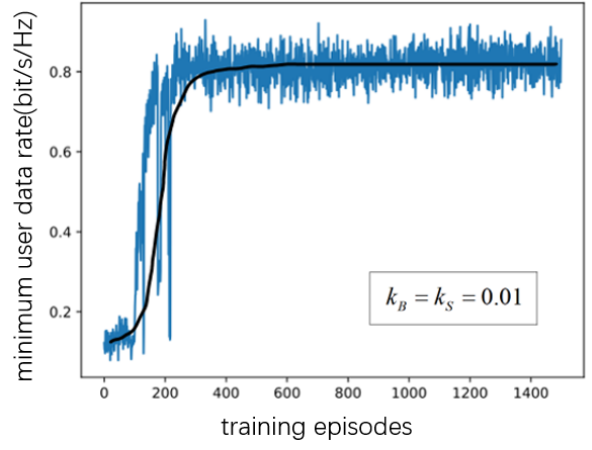
Figure 7. Convergence Speed when k B = k S = 0.01.